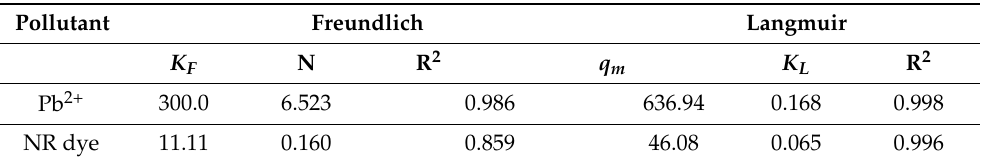
Table 1. Freundlich and Langmuir adsorption isotherms different parameters for Pb 2+ ions and NR dye adsorption over MnFe 2 O 4 /GO nanocomposite.